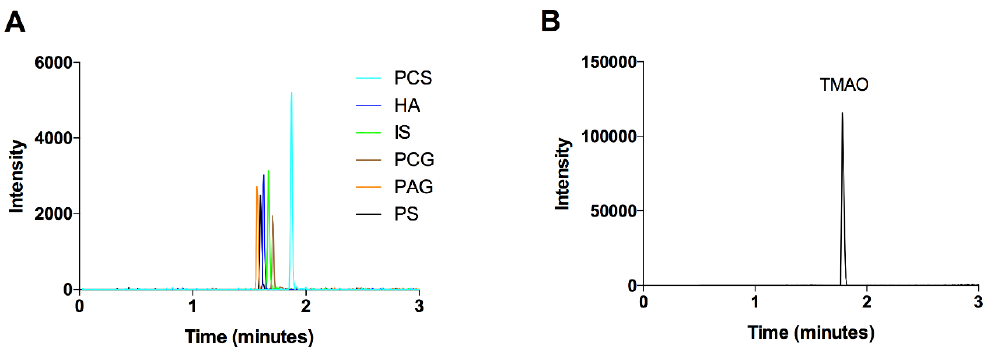
Figure 1. Representative chromatograms of metabolites of the intestinal microbiome. ( A ) Extracted ion chromatograms for p-cresyl sulfate (PCS), hippuric acid (HA), indoxyl sulfate (IS), p-cresyl glucuronide (PCG), phenylacetylglutamine (PAG), and phenyl sulfate (PS) were overlaid. These metabolites were measured using reverse phase liquid chromatography. ( B ) Extracted ion chromatogram of trimethylamine N-oxide (TMAO) which was measured by hydrophilic interaction liquid chromatography.